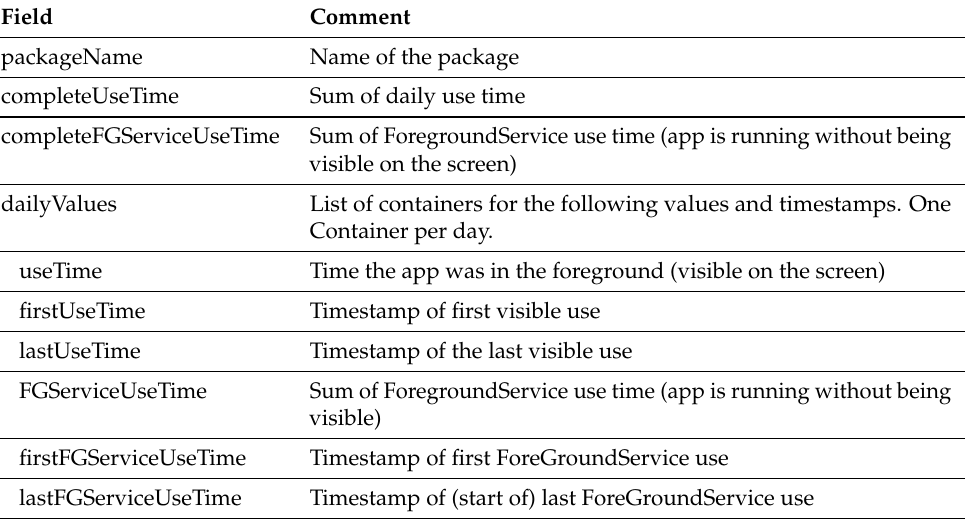
Table 2. Values stored for each app that is being recorded